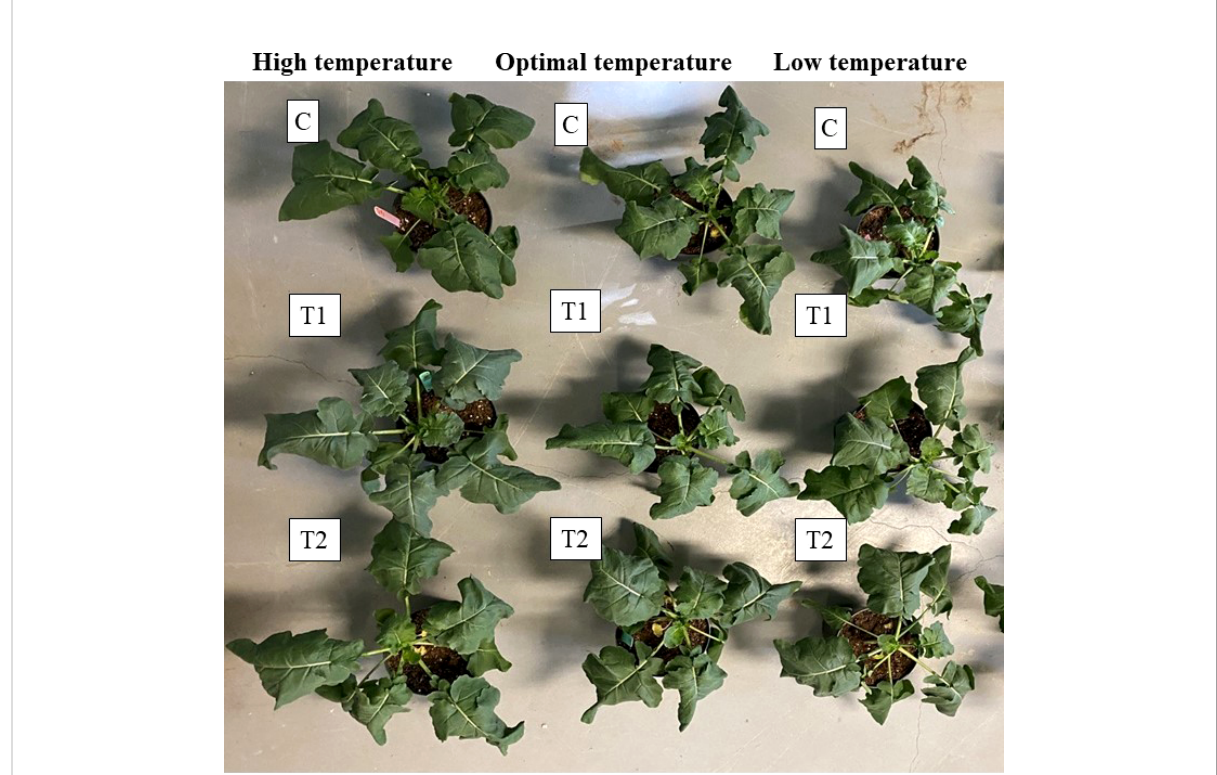
FIGURE 10 The effect of different temperatures and two of the best Th17 concentrations on canola growth and development. 7-week-old canola plants grown under high (30/25 °C, the fi rst column of plants), optimal (22/18 °C, the second column of plants) and low (10/5 °C, the third column of plants) temperatures. C: seeds treated with distilled water and plants watered with water during temperature stress, T1: 10 -9 M Th17 applied as seed treatment before sowing and root irrigation during temperature stress induction, T2: 10 -11 M Th17 applied as seed treatment before sowing and root irrigation during temperature stress induction.